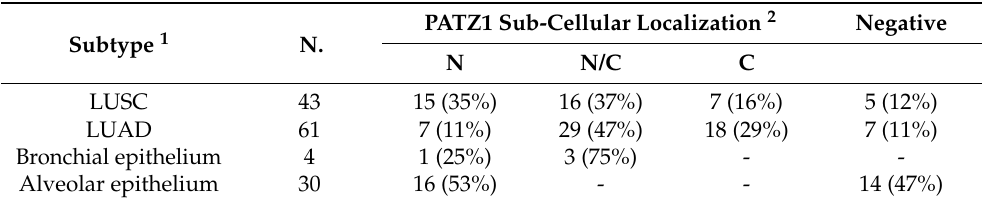
Table 2. PATZ1 expression and sub-cellular localization in NSCLC and adjacent non-tumor epithelium.